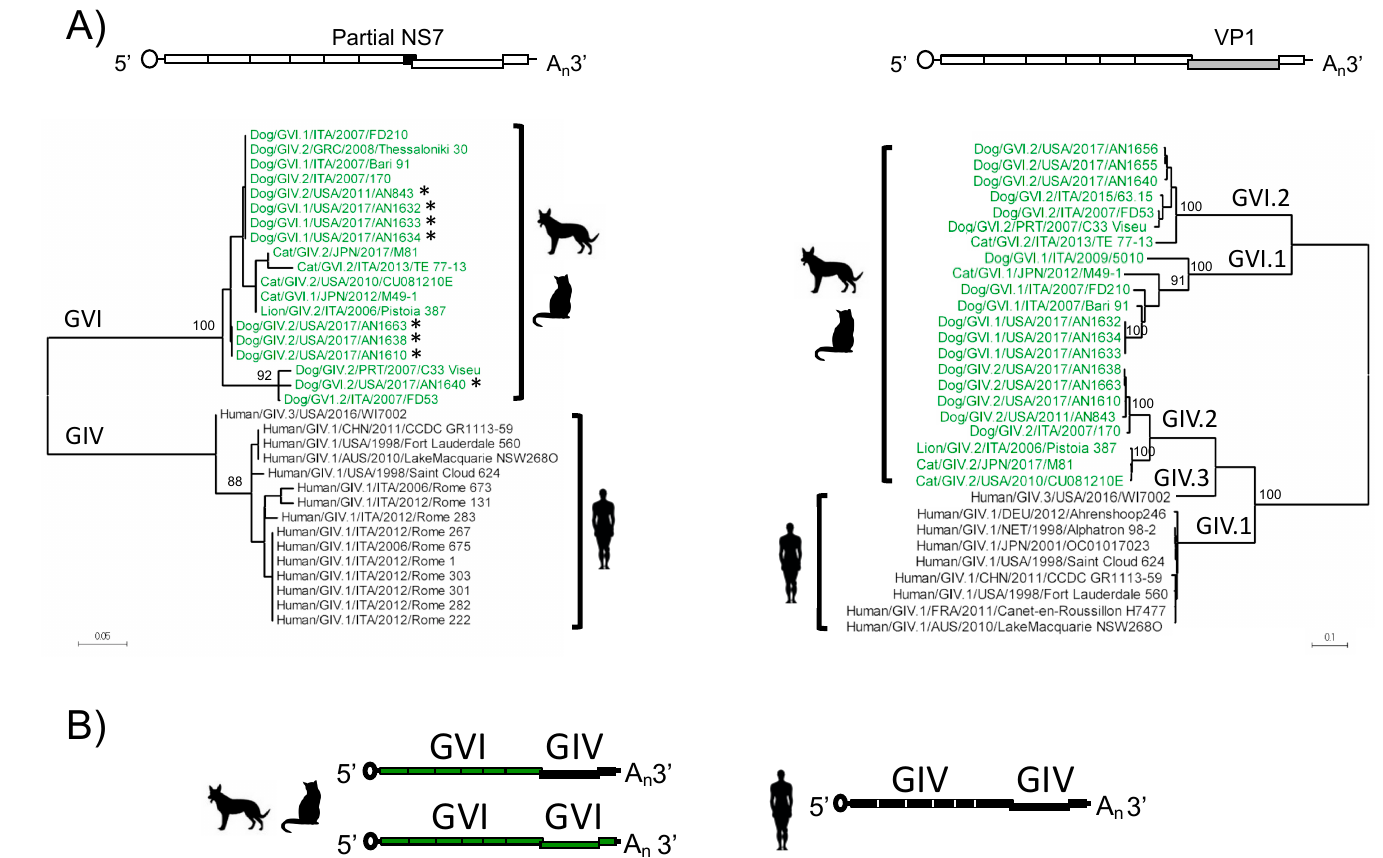
Figure 4. The GIV and GVI polymerases are clustered into two distinct groups. ( A ) A maximum likelihood tree of the partial polymerase (aa 427–512) based on the JTT matrix-based model. The phylogenetic tree was calculated with MEGA software (version 7.0.18). Strains described in this study are labeled with an asterisk (*). Strains highlighted in green and black represent animal and human noroviruses, respectively. A diagram of the genome indicating the region used for the analyses (black) is shown on top. ( B ) An illustration of recombinant norovirus genome organization representing the GIV and GVI viruses.